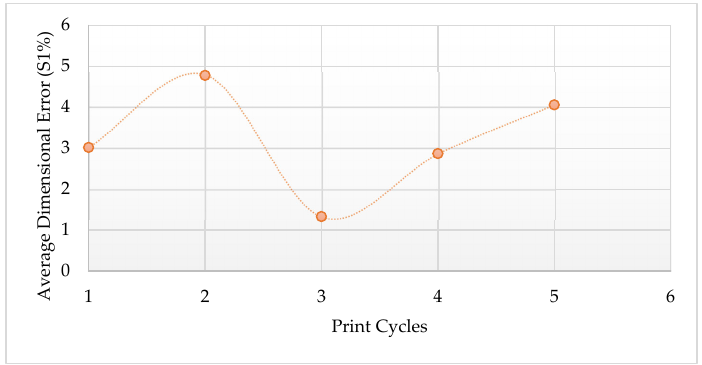
Figure 21. Average dimensional error for parts printed using Laser PP CP 75.